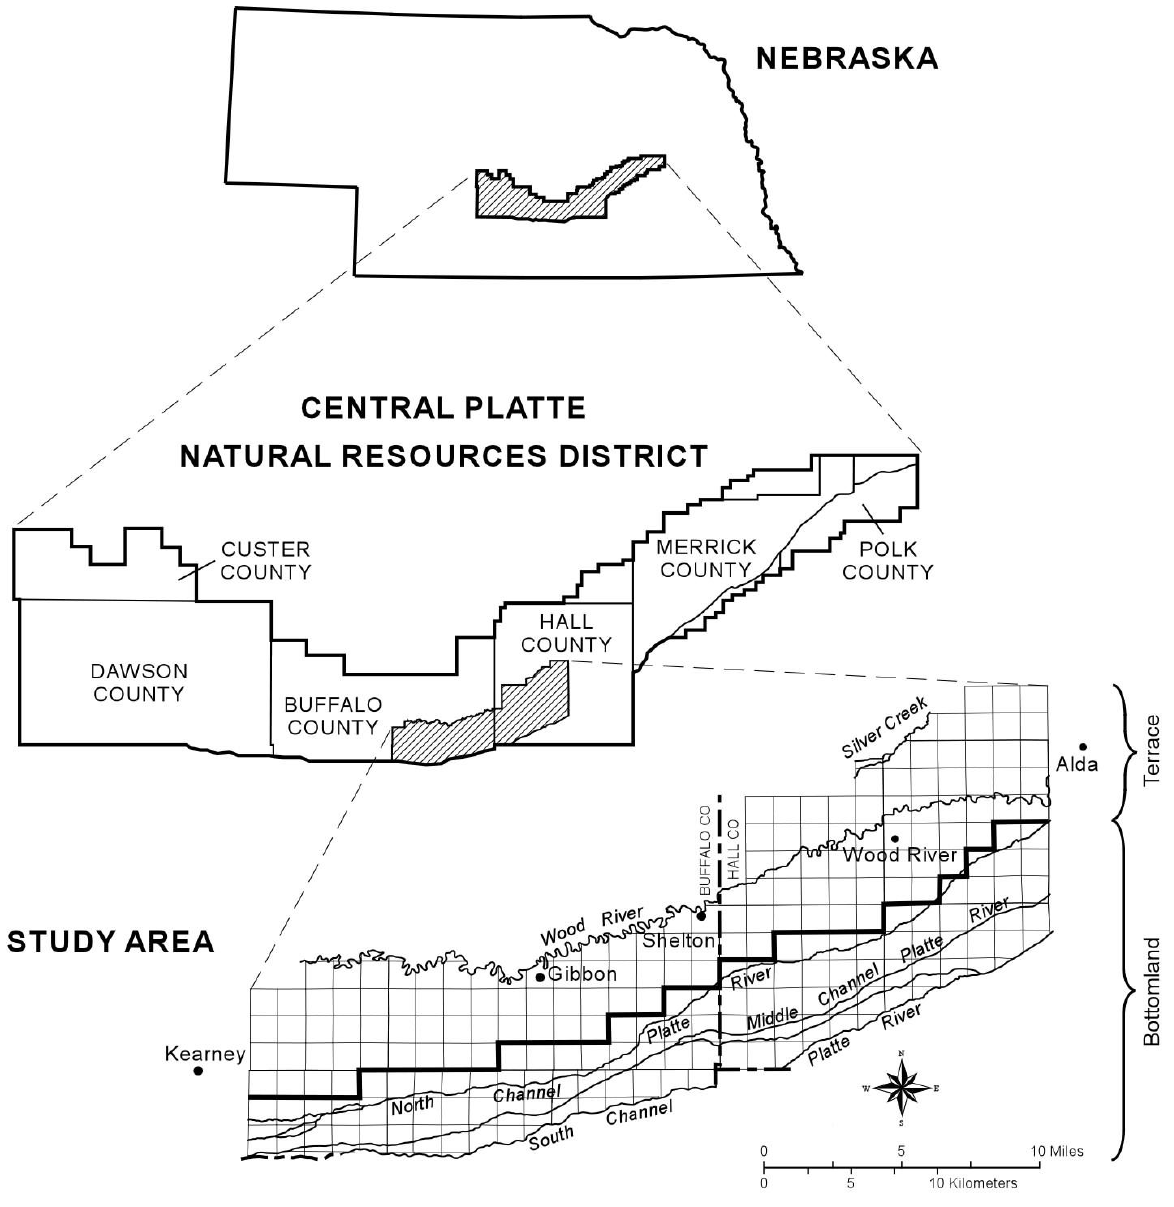
FIGURE 1. CPNRD Phase III groundwater quality management area in Buffalo and Hall Counties of Nebraska. The bold black line in the bottom panel represents the topographical divide between the bottomland and